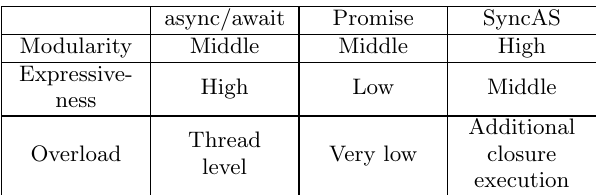
Table 1: Comparison by Modularity, Expressiveness,